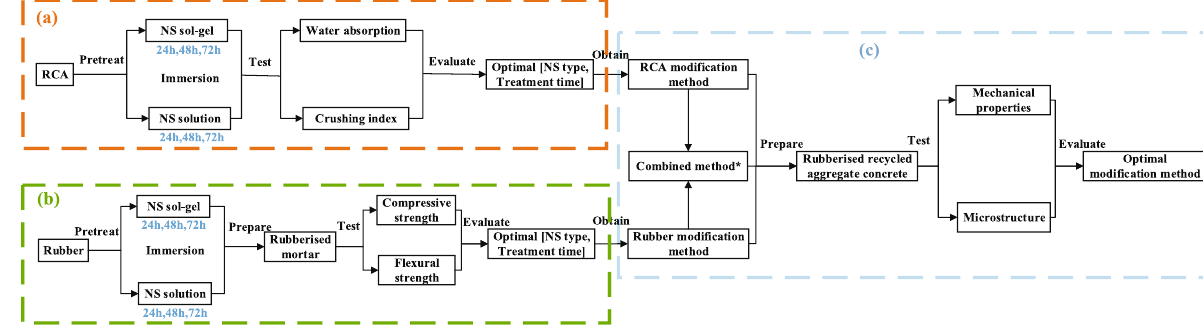
Figure 4: Treatment methods: ( a ) Treatment methods of RCA; ( b ) treatment methods of rubber for preparing rubberised mortar; and (